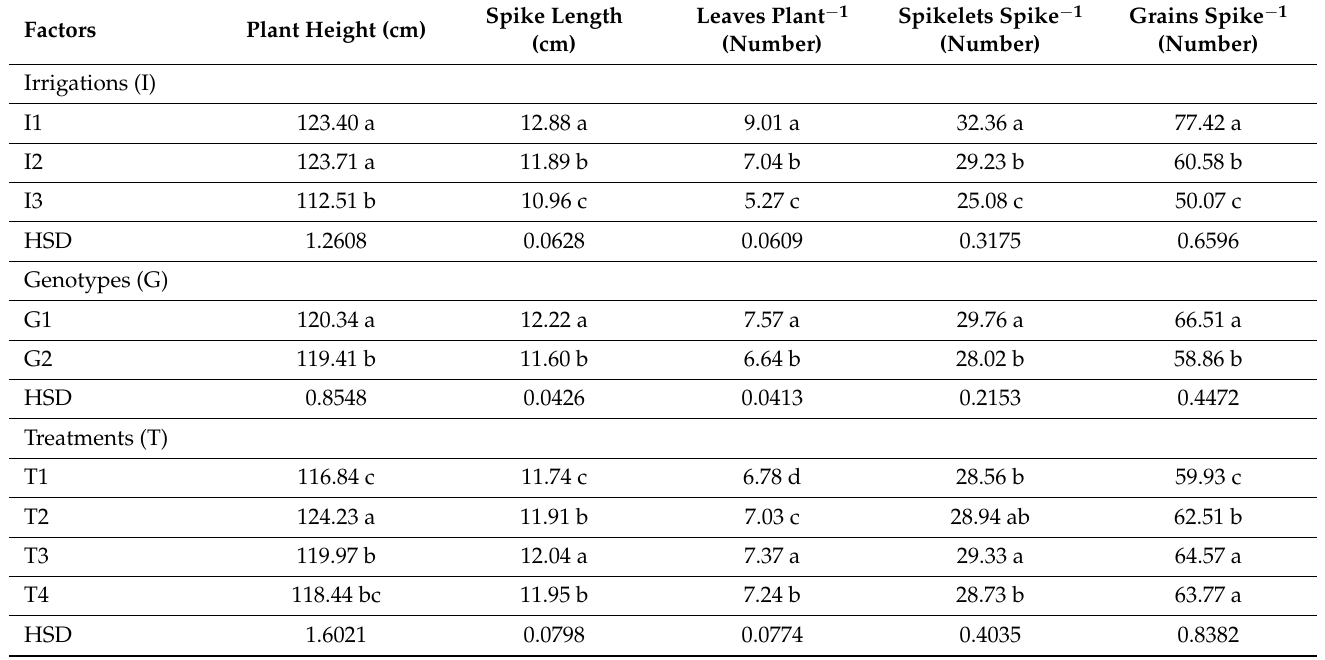
Table 4. Impact of NPK and organic amendments on plant height, spike length, number of leaves per plant, number of spikelets per spike and number of gains per spike of triticale genotypes cultivated under various irrigation